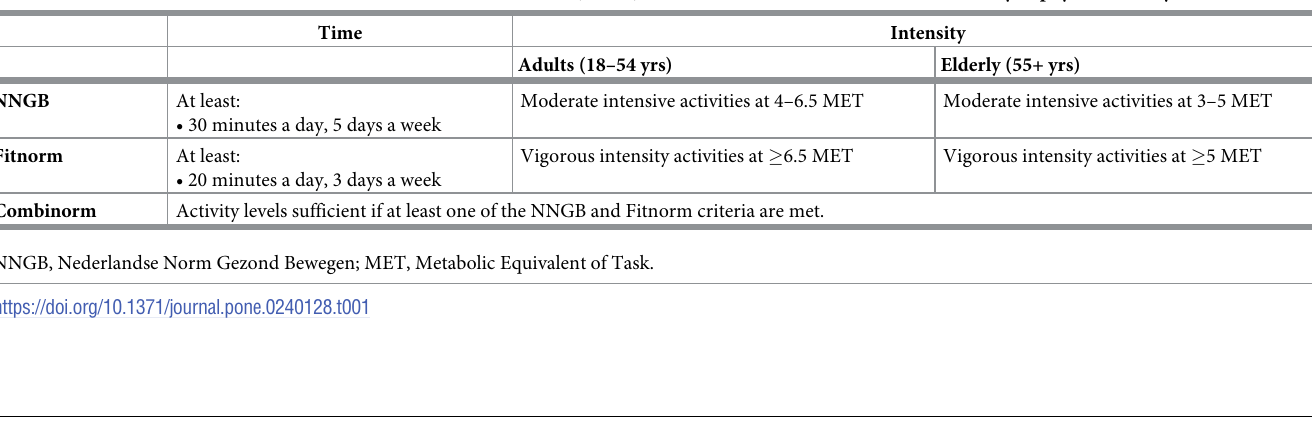
Table 1. Dutch National Institute for Public Health and Environment (RIVM) recommendations for duration and intensity of physical